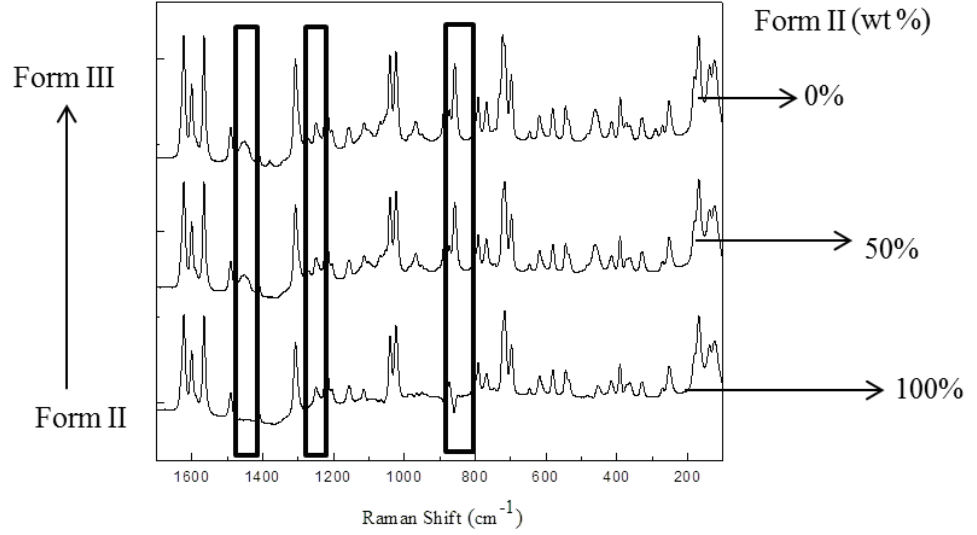
Figure 7. The Raman spectrum of polymorphs at different ratios.